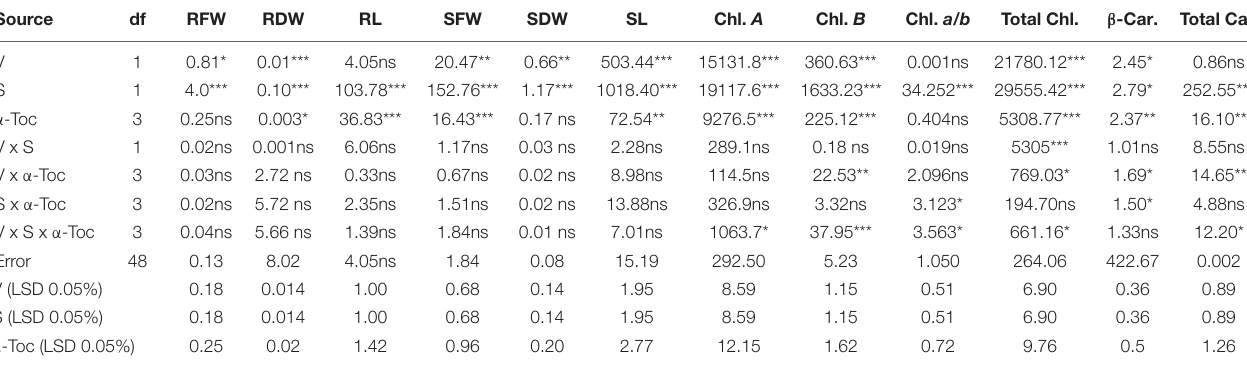
TABLE 1 | Analysis of variance (mean squares) for growth traits and photosynthetic attributes of okra plants treated with α -tocopherol as foliar spray under saline and non-saline conditions. Source